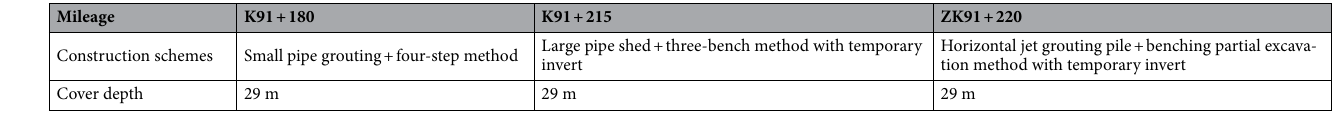
Table 13. General information of tunnel